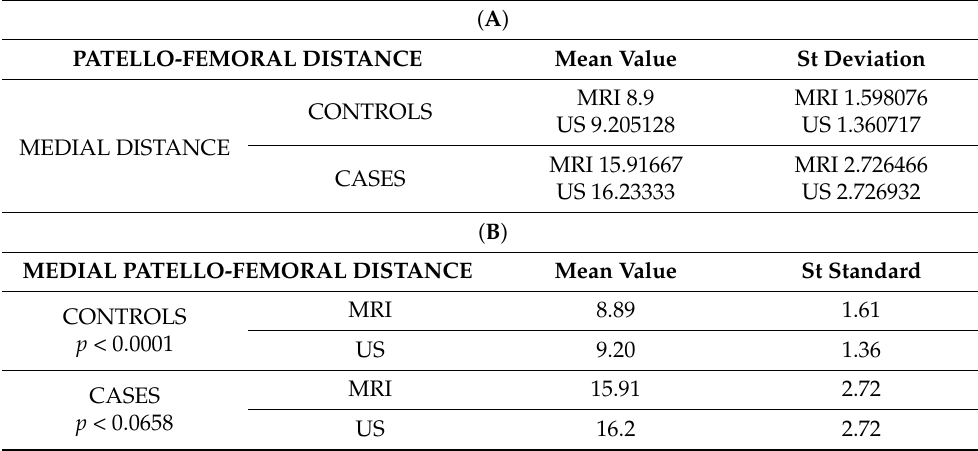
Table 4. ( A , B ) Student’s t -test. Patello-Femoral Distance. ( A ). Student’s t -test to differentiate me- dial patello-femoral distance in cases and controls in both MRI and US. The difference in media values of medial patello-femoral distance in cases and controls is statistically significant using the Student’s t -test. Medial Patello-Femoral Distance. MRI (Media cases = 15.9 ± 2.72 mm e media controls= 8.9 ± 1.59 mm). US (Media cases= 16.2 ± 2.72 mm e media controls = 7.0 ± 1.36 mm). ( B ). Student’s t -test to compare the media values of MRI AND US to evaluate patello-femoral distance in cases and controls. Overlapping of results obtained in cases using MRI and US. No statistically significant differences. Medial patello-femoral distance (Media MRI: 15.9 ± 2.72 mm, Media US: 16.2 ± 2.72 mm). Controls show a statistically significant difference. Medial patello-femoral distance (Media MRI: 8.89 ± 1.61 mm, Media US: 9.2 ± 1.36 mm).